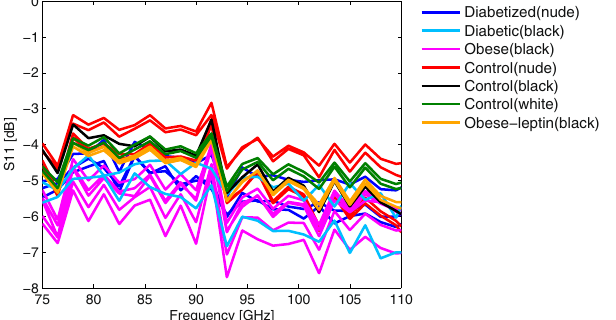
Figure 1. Amplitude of the reflection coefficient S(1, 1) versus frequency for the different mice